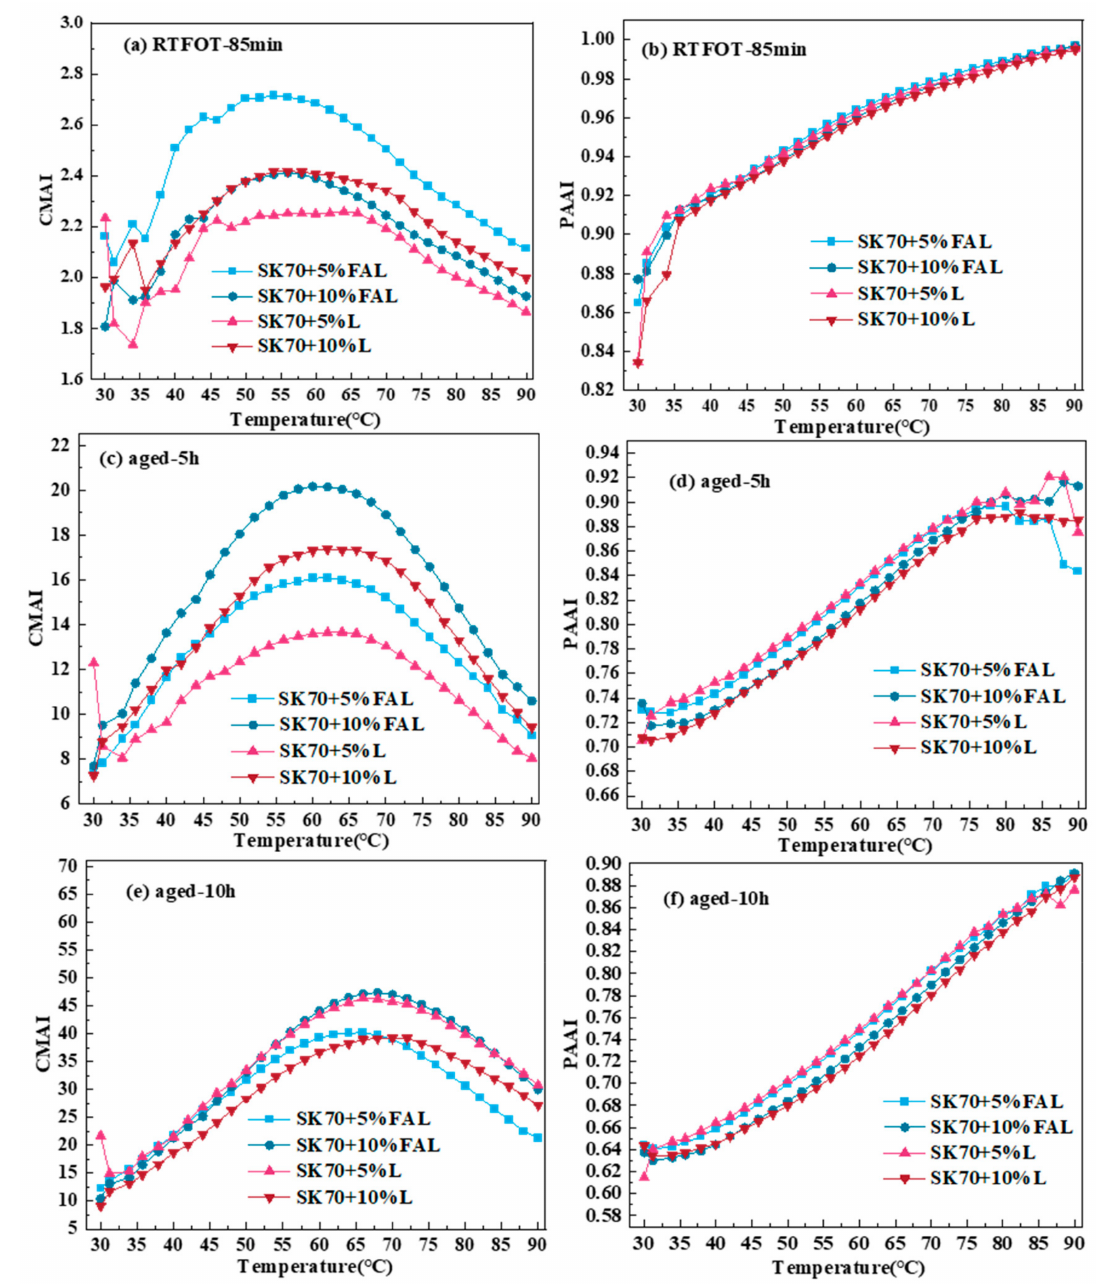
Figure 7. Curves of complex modulus aging and phase angle aging indexes with temperatures for each asphalt specimen during different aging